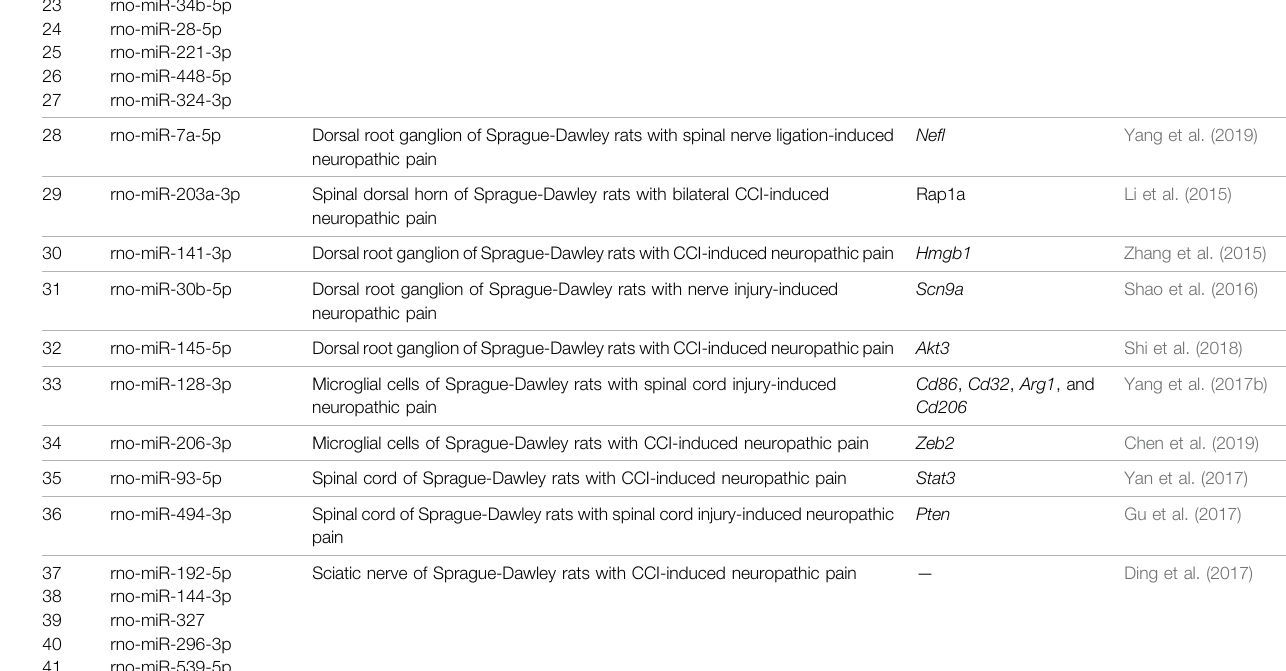
TABLE 6 | Downregulated rat microRNAs involved in neuropathic pain. Sr. miRNA Biological matrix (cell No. rno-miR-183-5p